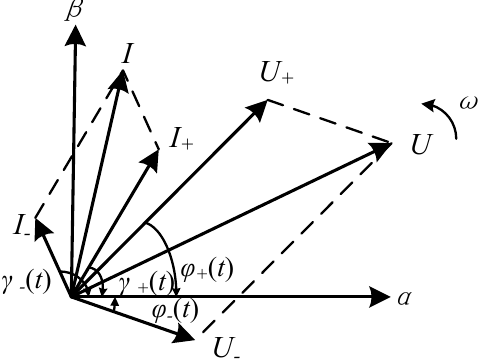
Figure 3. The positive and negative sequence components diagram.